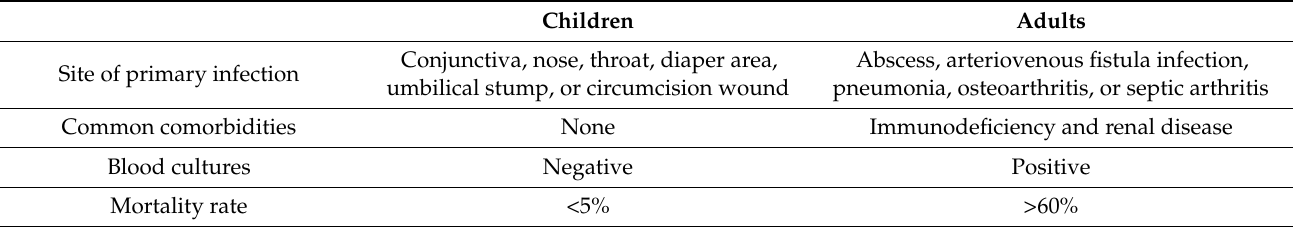
Table 1. Clinical features of children and adults with